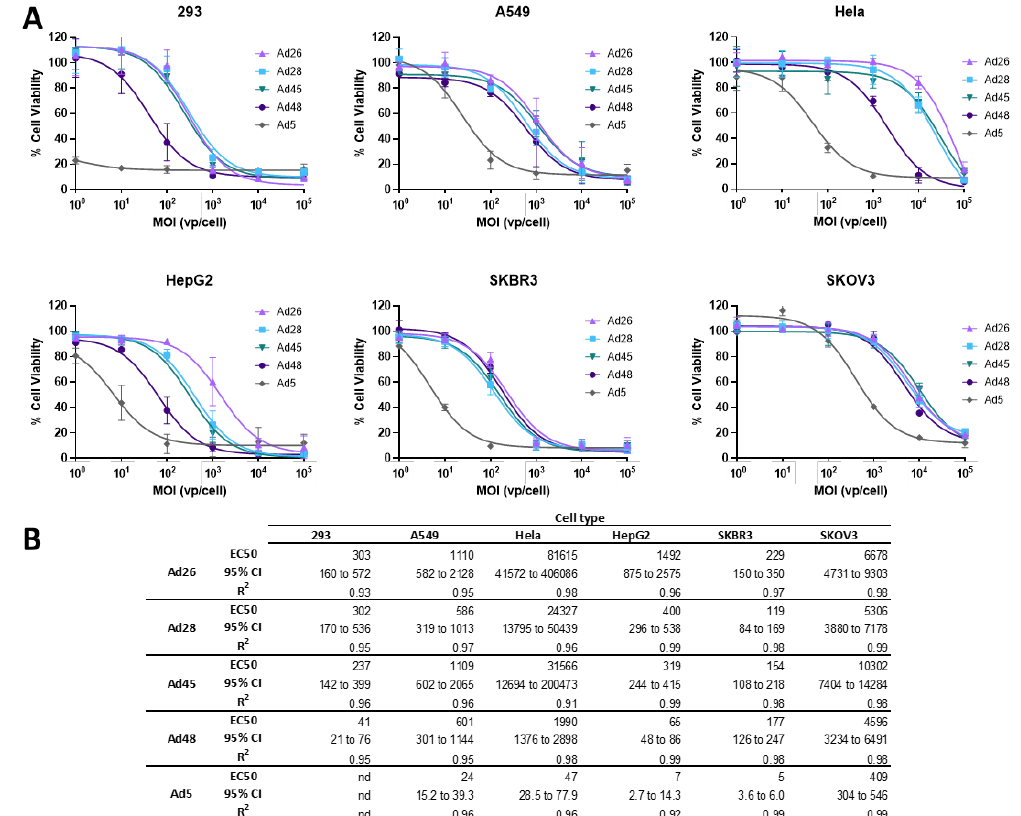
Figure 5. Oncolytic activity of the wild type species D Ads and wild type Ad5. ( A ) The half maximal effective concentration (EC50) of the wild type viruses were determined by infecting cells with serial dilutions of the indicated virus and evaluating cell death 5 days post infection by an MTT assay. Cell viability was determined by comparison to uninfected cell controls. Data is presented as mean ± standard deviation (SD) from three independent experiments. ( B ) EC50s, 95% confidence intervals, and R 2 values are shown in the table.